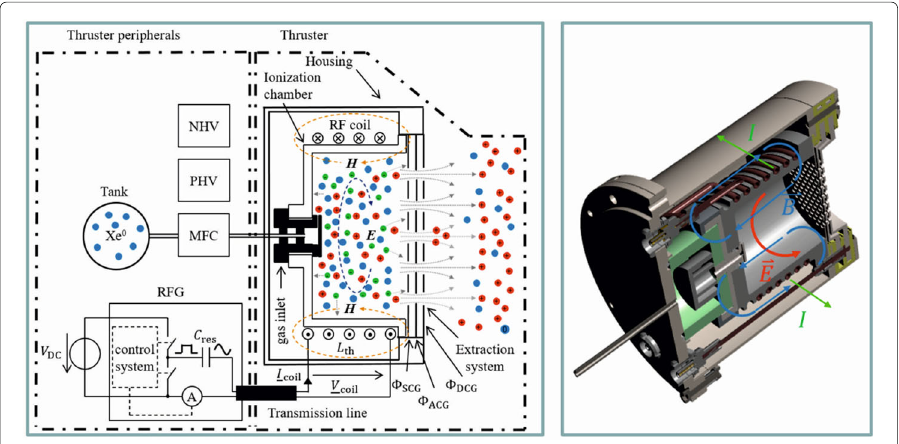
Fig. 1 Left: RF ion thruster assembly including peripheral HV supplies (negative: NHV, positive: PHV), mass flow controller (MFC) and radio-frequency generator (RFG). The screen grid is floating, since the PHV-supply is connected to the gas inlet instead of the screen grid. Right: CAD drawing of the RIT-4 benchmark thruster used in this paper incl. coil current, electric and magnetic